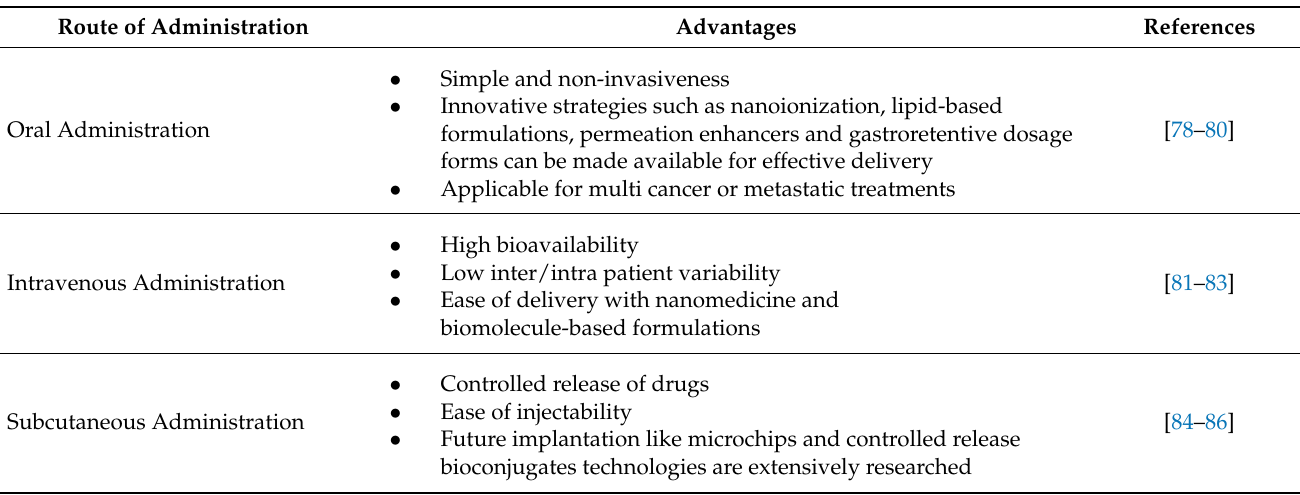
Table 2. Route of administration for cancer immunotherapy.